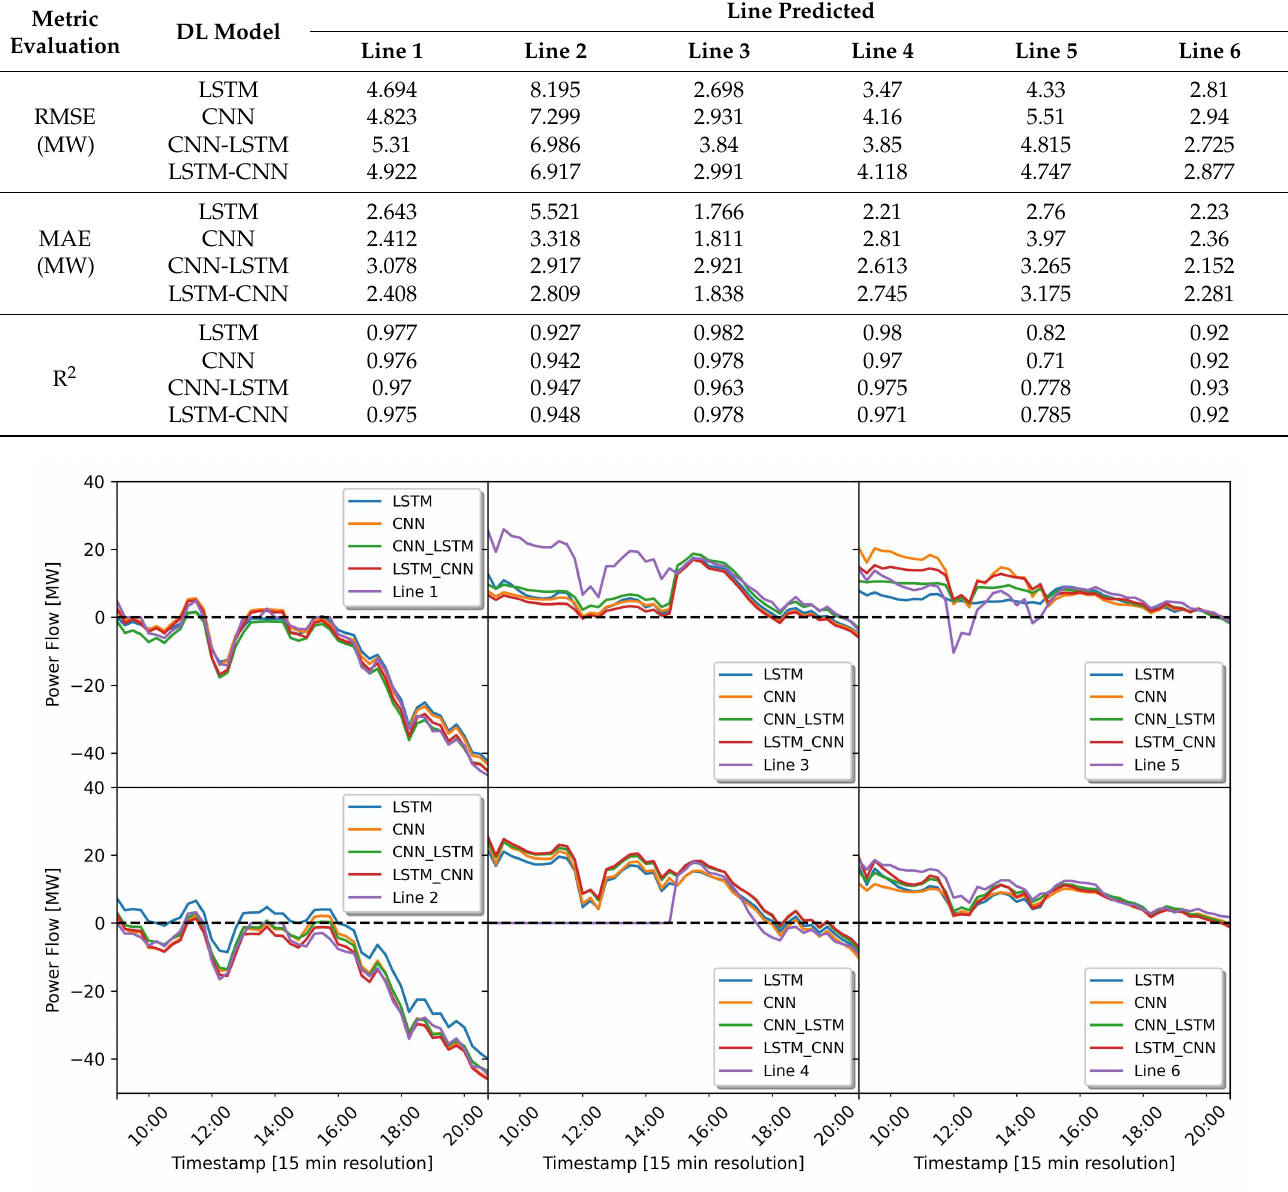
Figure 10. Prediction results of the power flow direction based on real power measurement data only.